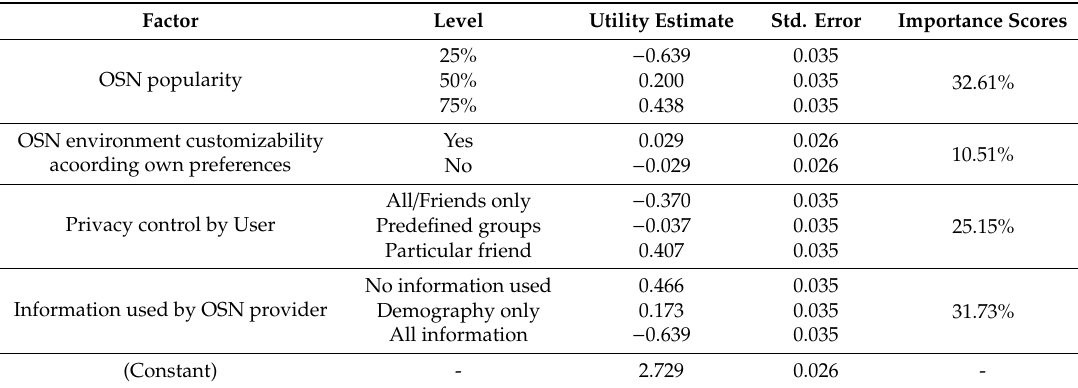
Table 3. Aggregated customer